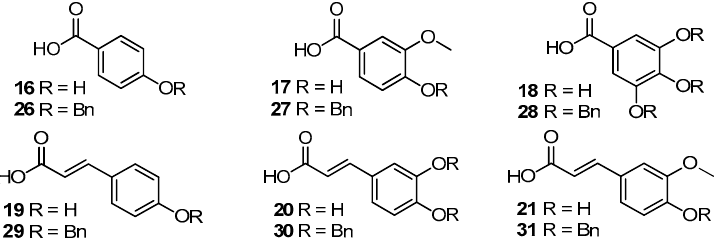
Figure 3. Aromatic acids 16 – 21 and their protected forms 26 – 31 used for the chemical approach.